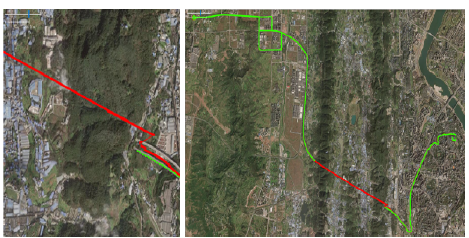
Figure 11. Vehicle trajectory in real tunnel experiment (Green : GNSS; Red: GNSS/INS/NHC integration)